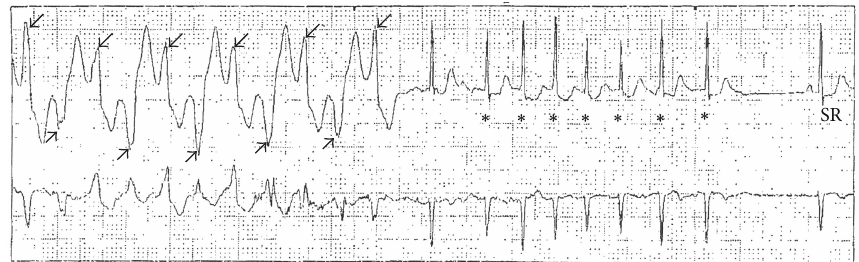
F 2: Rhythm strip from Holter monitor showing bidirectional VT, wide QRS complex tachycardia with alternating QRS axis (arrows), followed by nonsustained SVT, narrow QRS complex tachycardia (asterisks), then spontaneous termination to sinus rhythm